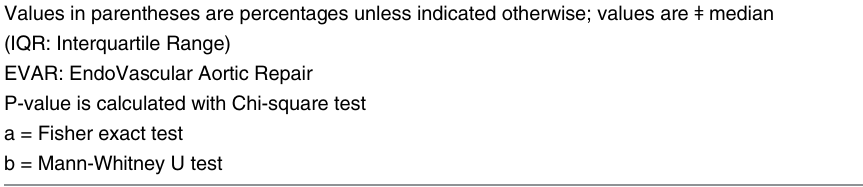
Values in parentheses are percentages unless indicated otherwise; values are ǂ